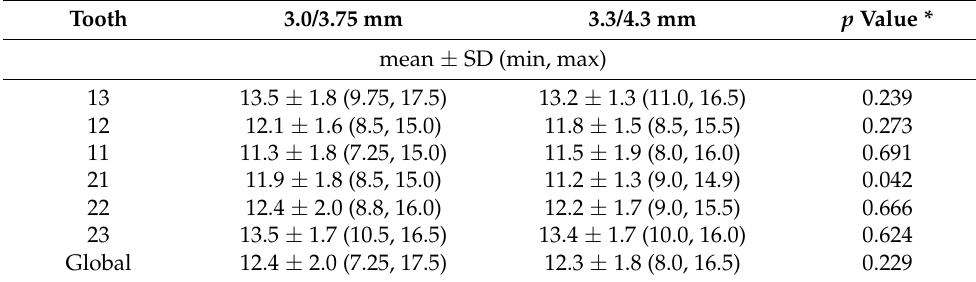
Table 3. Minimum length of the implants when planned in bone-driven position.